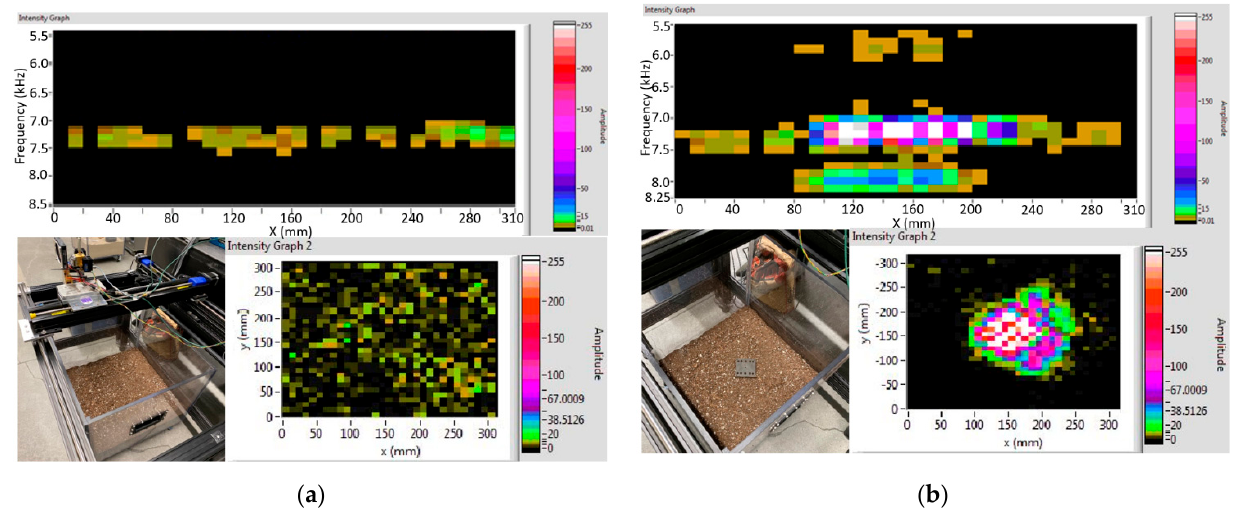
Figure 12. W–band underground imaging experiment results. ( a ) Background, ( b ) target object on soil.